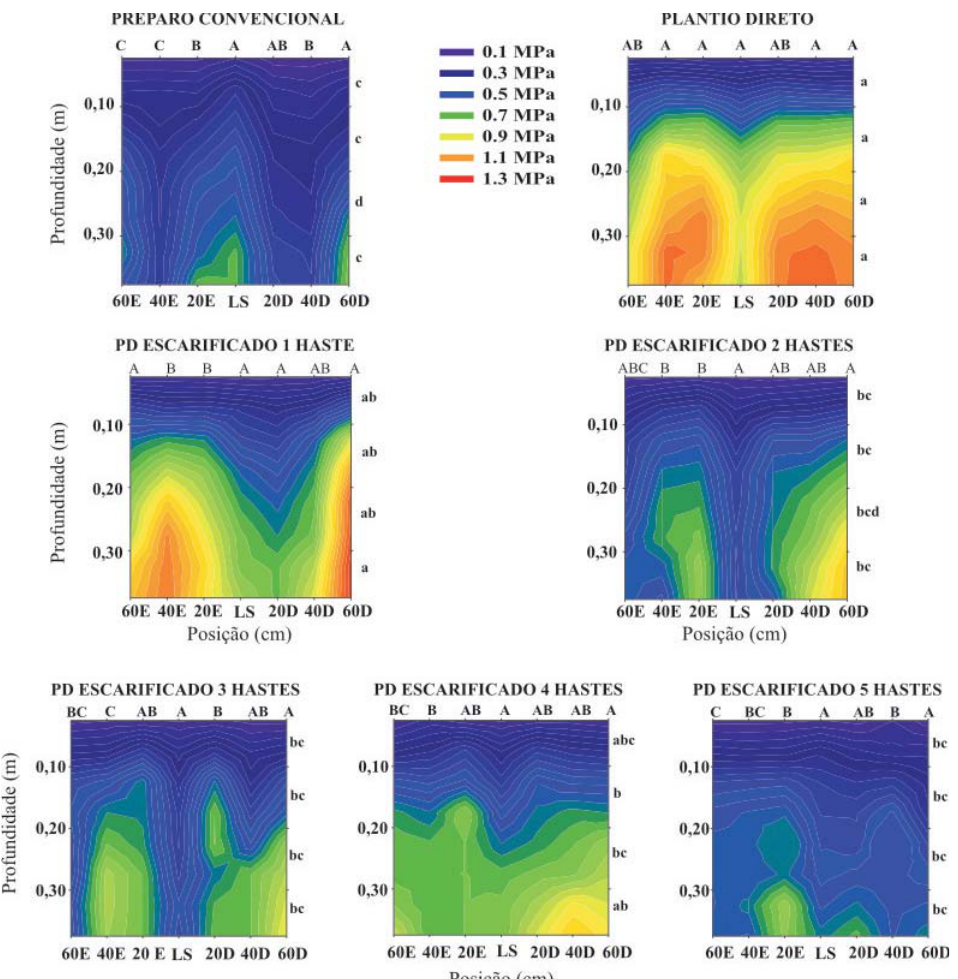
Figura 6. Resistência do solo à penetração em MPa até 40 cm de profundidade em pontos alinhados perpendicularmente à linha de semeadura, nos respectivos tratamentos de sistemas de cultivo do solo. (LS: ponto sobre a linha de semeadura; 20E: ponto 20 cm à esquerda da LS; 40E: ponto 40 cm à esquerda da LS; 60E: ponto 60 cm à esquerda da LS; 20D: ponto 20 cm à direita da LS; 40D: ponto 40 cm à direita da LS; e 60D: ponto 60 cm à direita da LS). Letras iguais em maiúscula na horizontal, para a mesma RP, tendo como referência a LS, entre os tratamentos, não diferem significativamente pelo teste de Duncan a 5 %; Letras iguais em minúscula na vertical, dentro da mesma faixa de profundidade, não diferem significativamente pelo teste de Duncan a 5